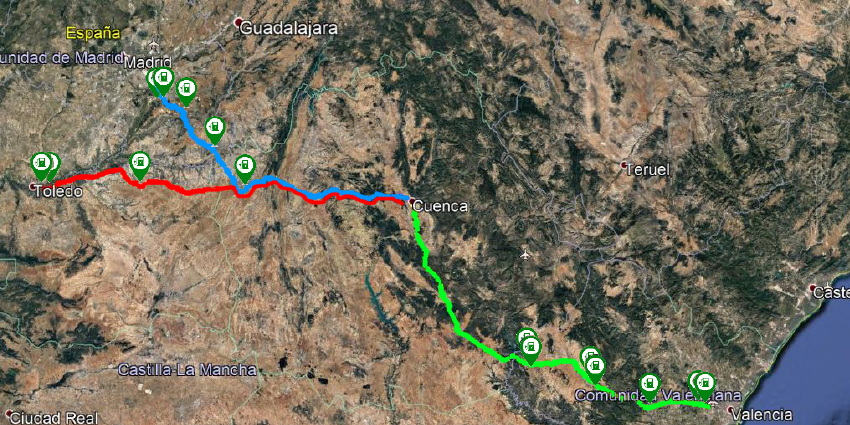
Figure 6. Actual charging stations on the routes starting from Cuenca to: Madrid (blue path), Valencia (green path) and Toledo (red